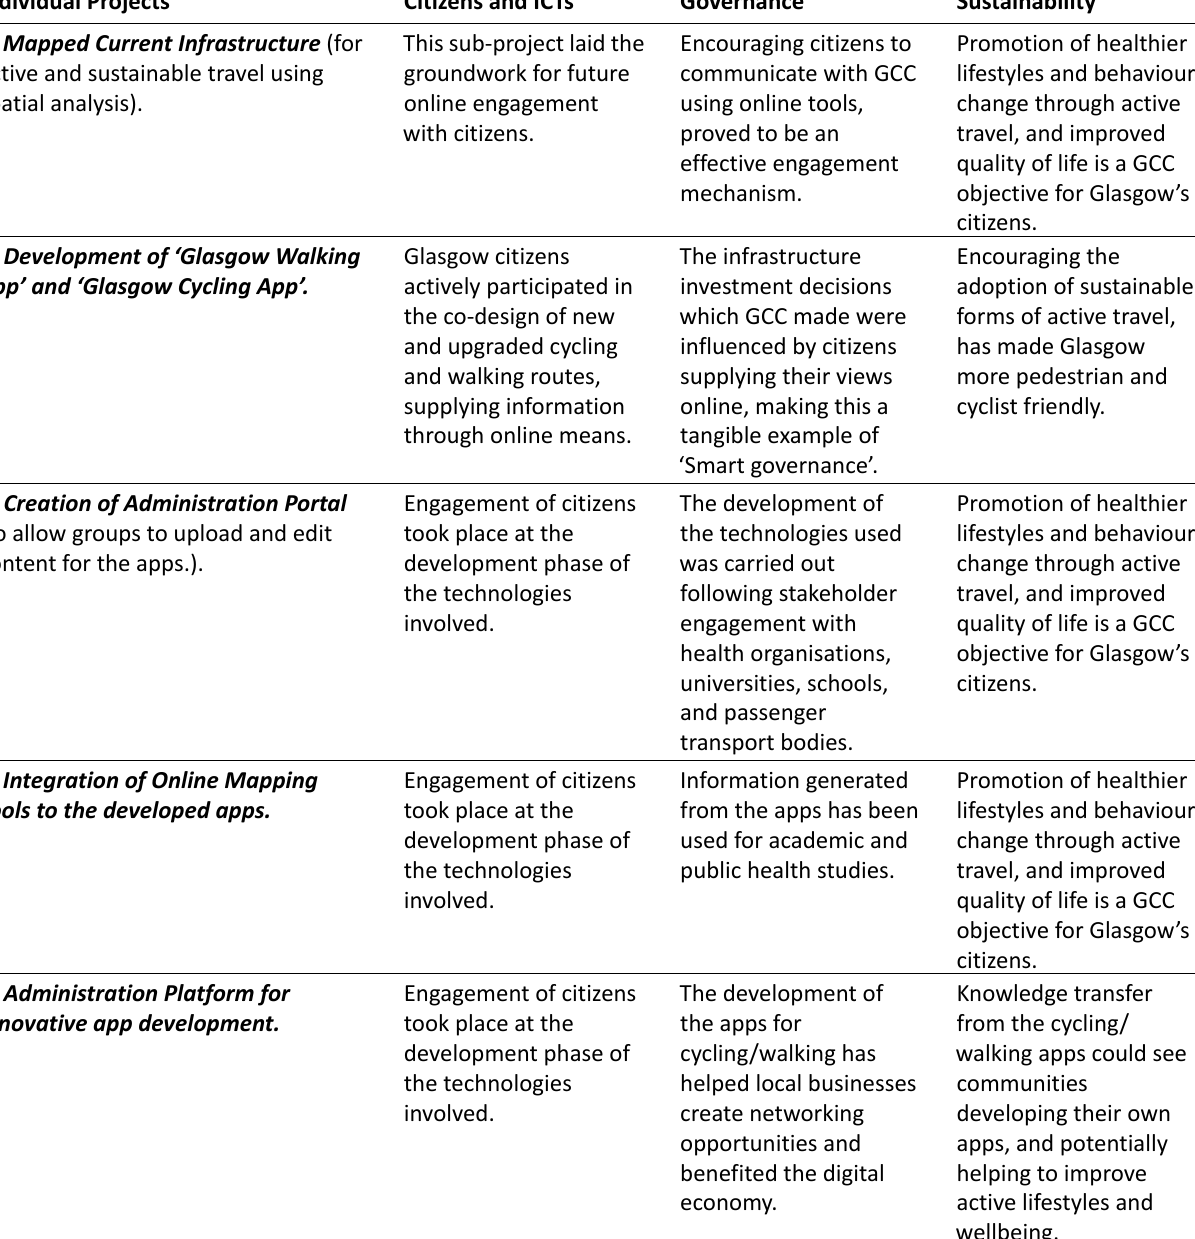
Table 4. Cycling and walking. Individual